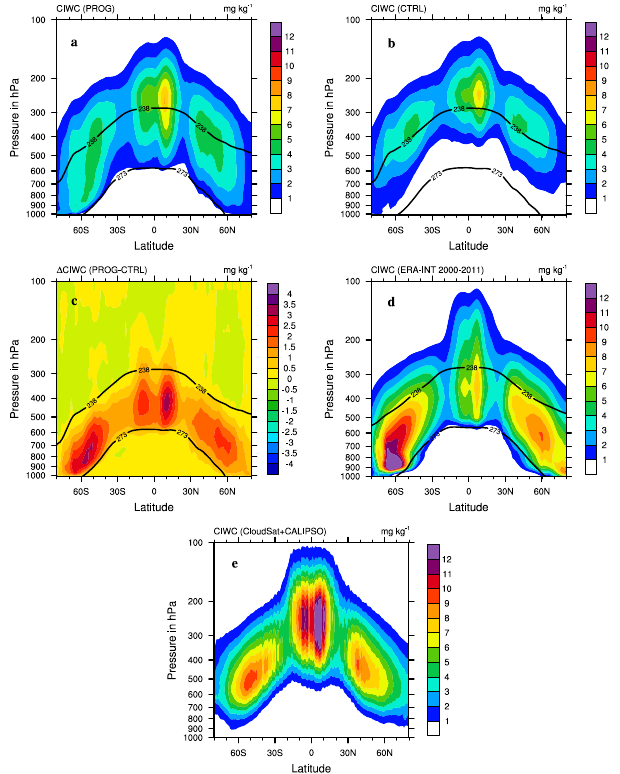
Figure 3. Annual mean ice water content of (a) PROG, (b) CTRL, (c) the difference PROG − CTRL, (d) ERA-interim reanalysis, and (e) CloudSat + CALIPSO, ensemble mean satellite observations of CloudSat and the Cloud-Aerosol Lidar and Infrared Pathfinder Satellite Observations (Li et al., 2012). The solid black lines in (a) – (d) represent the melting and the homogeneous freezing levels at T = 273 and T = 238K,